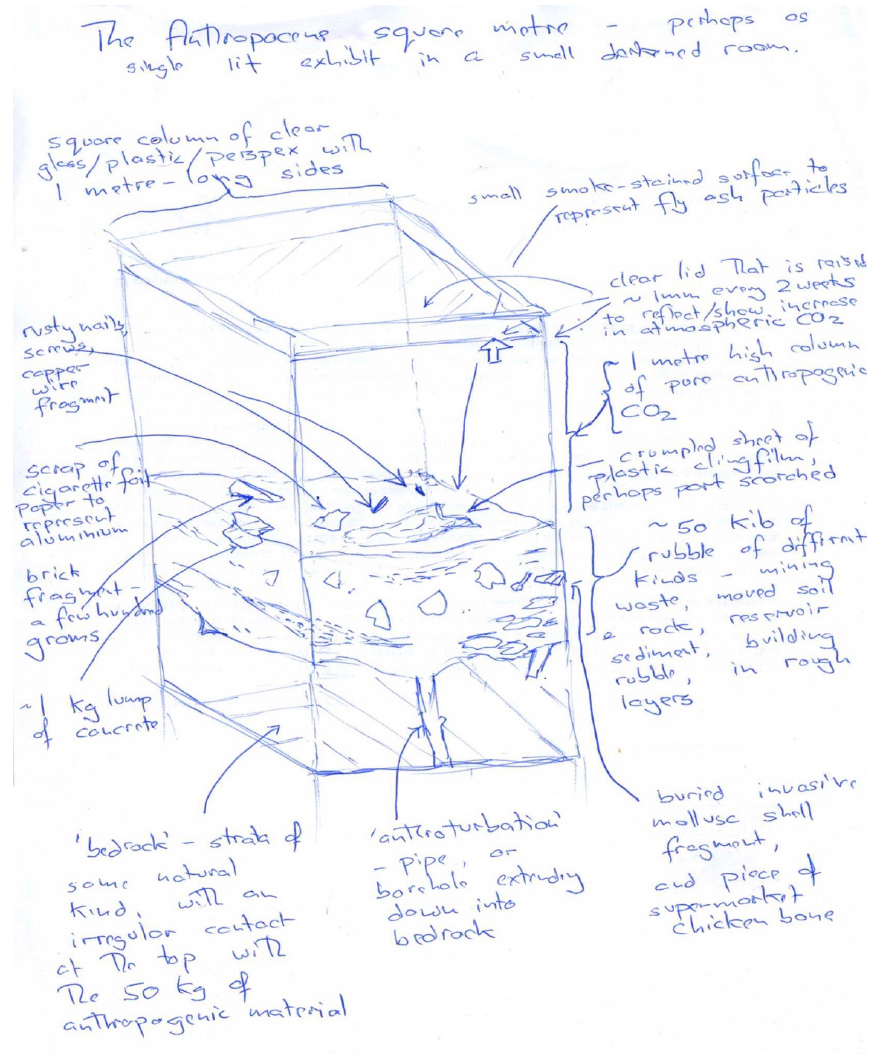
Figure 1. Zalasiewicz, The Anthropocene Square Meter, 2019. Sketch. (Zalasiewicz 2020, p. 37) (courtesy of the scientist).